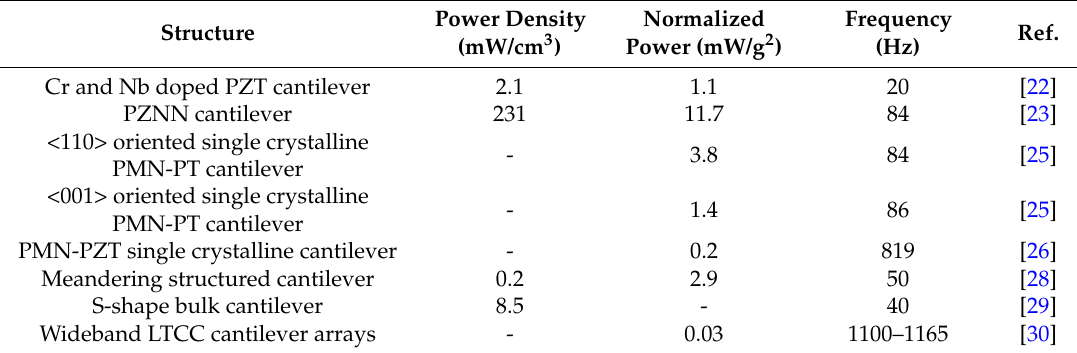
Table 1. Comparison of the output performance of the cantilever type bulk piezoelectric energy